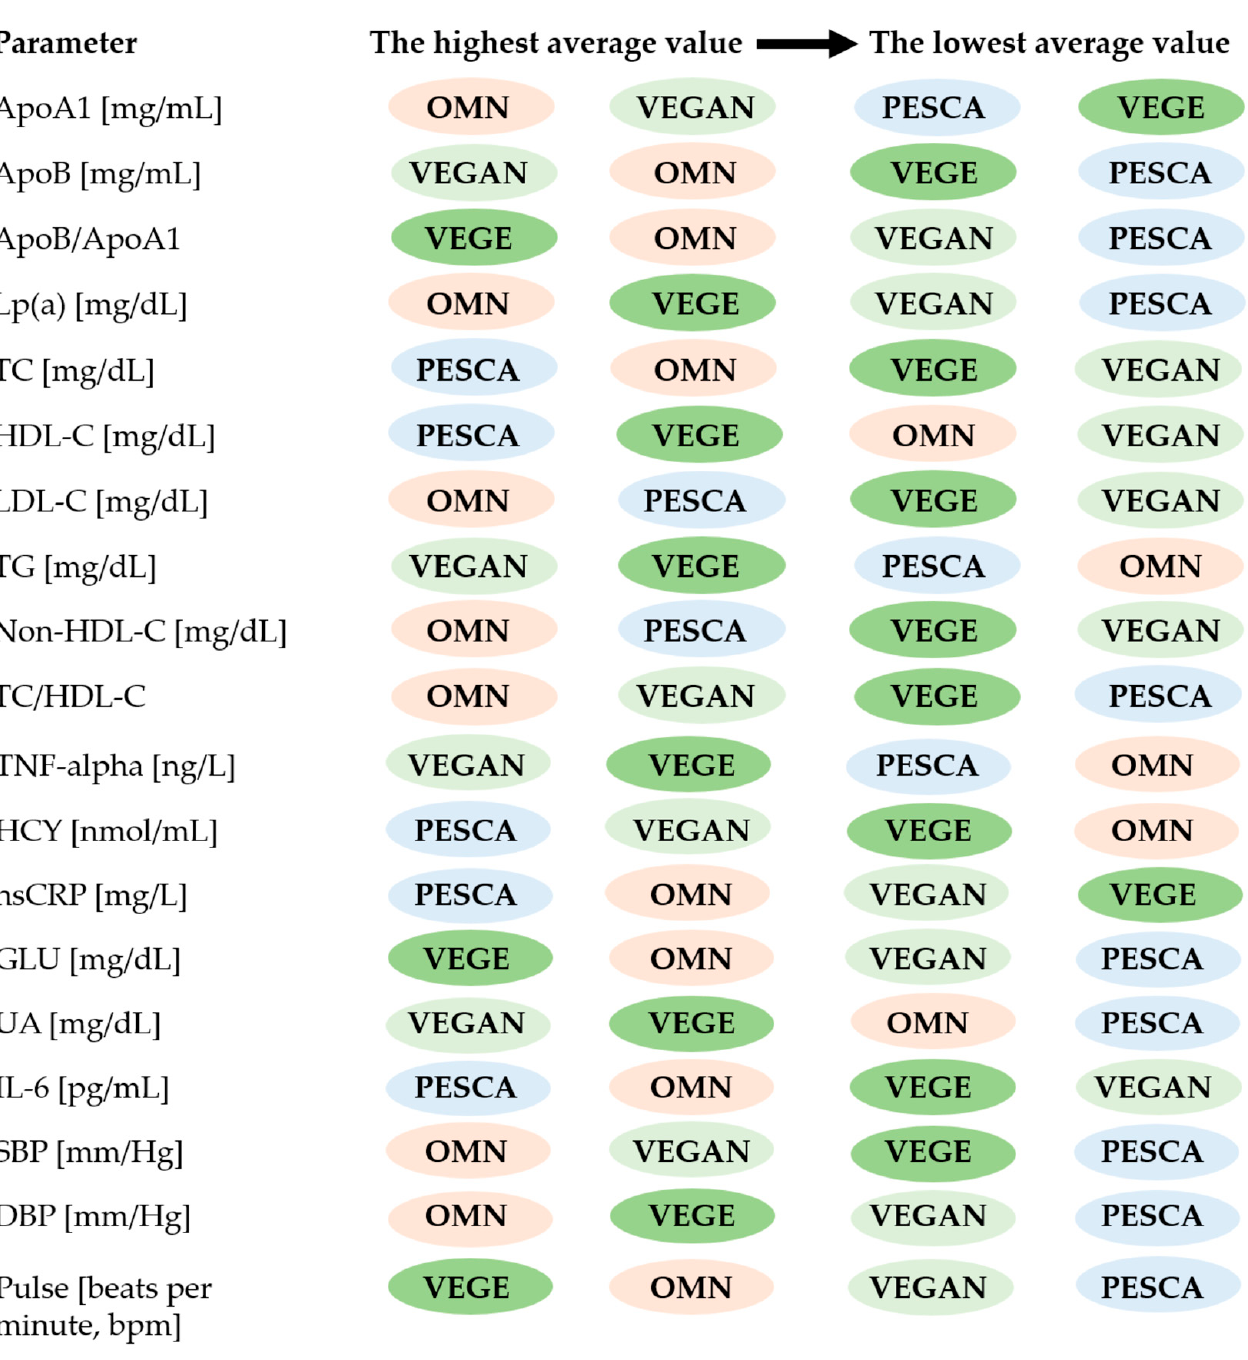
Figure 3. The highest and the lowest average values of biochemical parameters, pulse and blood pressure measurements in all groups marked with separate colors. Abbreviations: ApoA1— Apolipoprotein A1 , ApoB—Apolipoprotein B, ApoB/ApoA1—Apolipoprotein B/apolipoprotein A1 ratio, Lp(a)—Lipoprotein(a), TC—Total cholesterol, HDL-C—High-density lipoprotein cholesterol, LDL-C—Low-density lipoprotein cholesterol, TG—Triglycerides, Non-HDL-C—Non-high-density lipoprotein cholesterol, TC/HDL-C—Total cholesterol to high-density lipoprotein cholesterol ratio, HCY—Homocysteine, TNF-alpha—Tumor necrosis factor alpha, hsCRP—High sensitivity C- reactive protein, GLU—Glucose, UA—Uric acid, IL-6—Interleukin 6, SBP—Systolic blood pressure, DBP—Diastolic blood pressure.